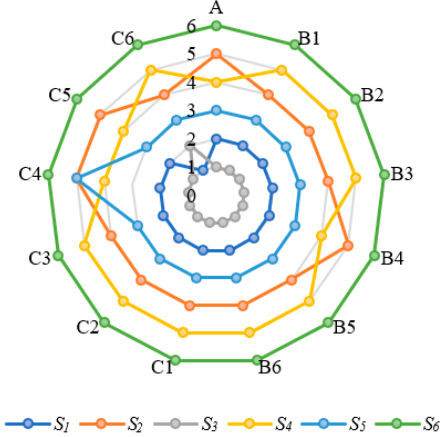
Figure 5. The variation rankings of Groups A–C in the sensitivity analysis. Table 19. Rankings with di ff erent multi-criteria decision-making (MCDM)